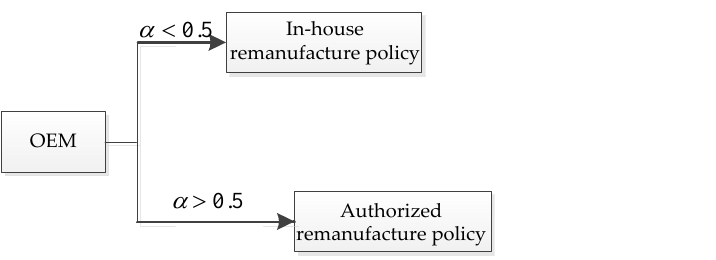
Figure 18. The effect of the green innovation efforts on OEMs’ remanufacturing strategies.